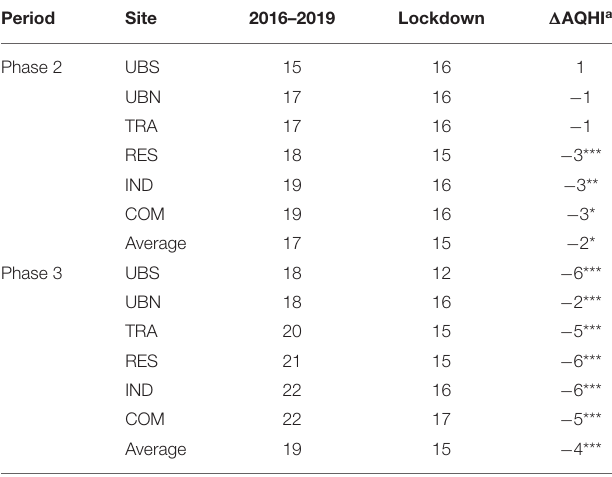
TABLE 3 | Averages and changes in maximum daily AQHI values during 2016–2019 and lockdown Phases 2–3 by monitoring site within the MCMA. Period